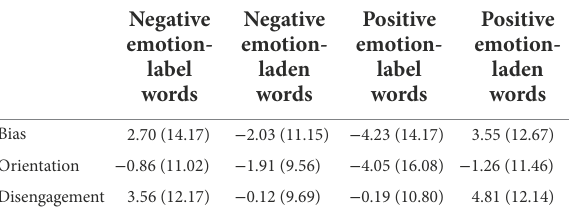
TABLE 3 The descriptive data of attentional bias, orientation, and disengagement